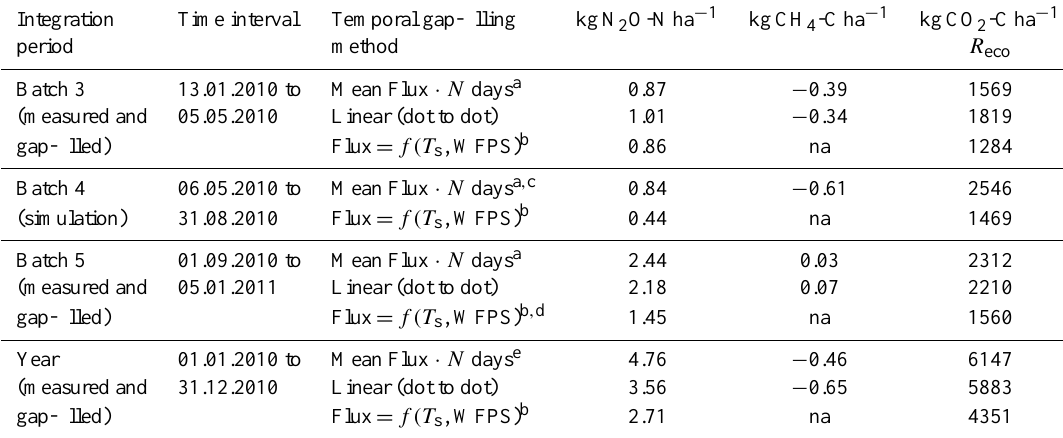
Table 4. GHG fluxes at the batch and annual time scales, using alternative temporal integration